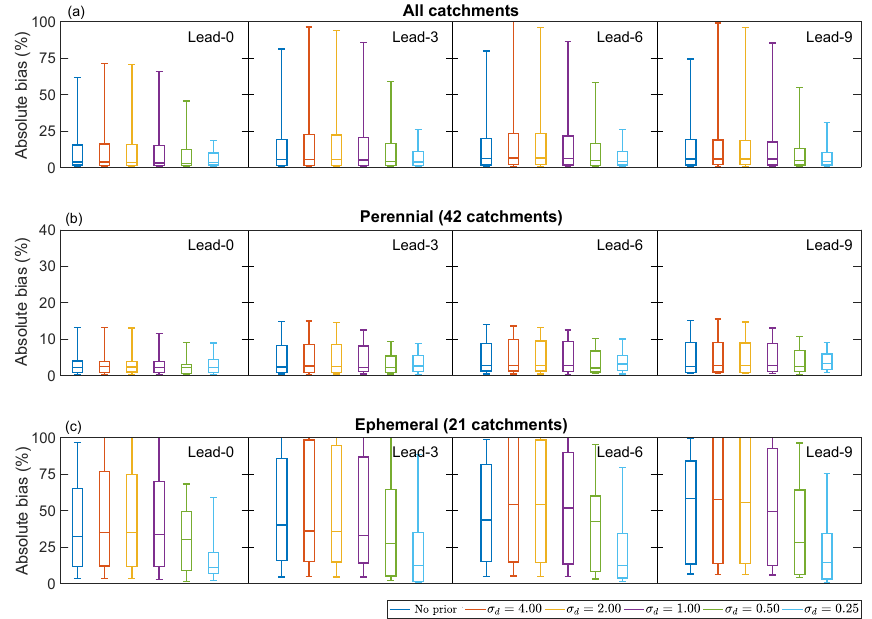
Figure 12. Absolute bias in 63 catchments by lead time for FoGSS forecasts with different strength priors on the d parameter (smaller values of σ d result in a stronger prior). For each lead time, absolute bias is summarized for all months with box and whisker plots. Boxes show the interquartile range with the median; whiskers give the 10th and 90th percentiles. (a) shows results for all catchments, (b) for perennial catchments only, and (c) for ephemeral catchments. Note the differently scaled vertical axis of (b)